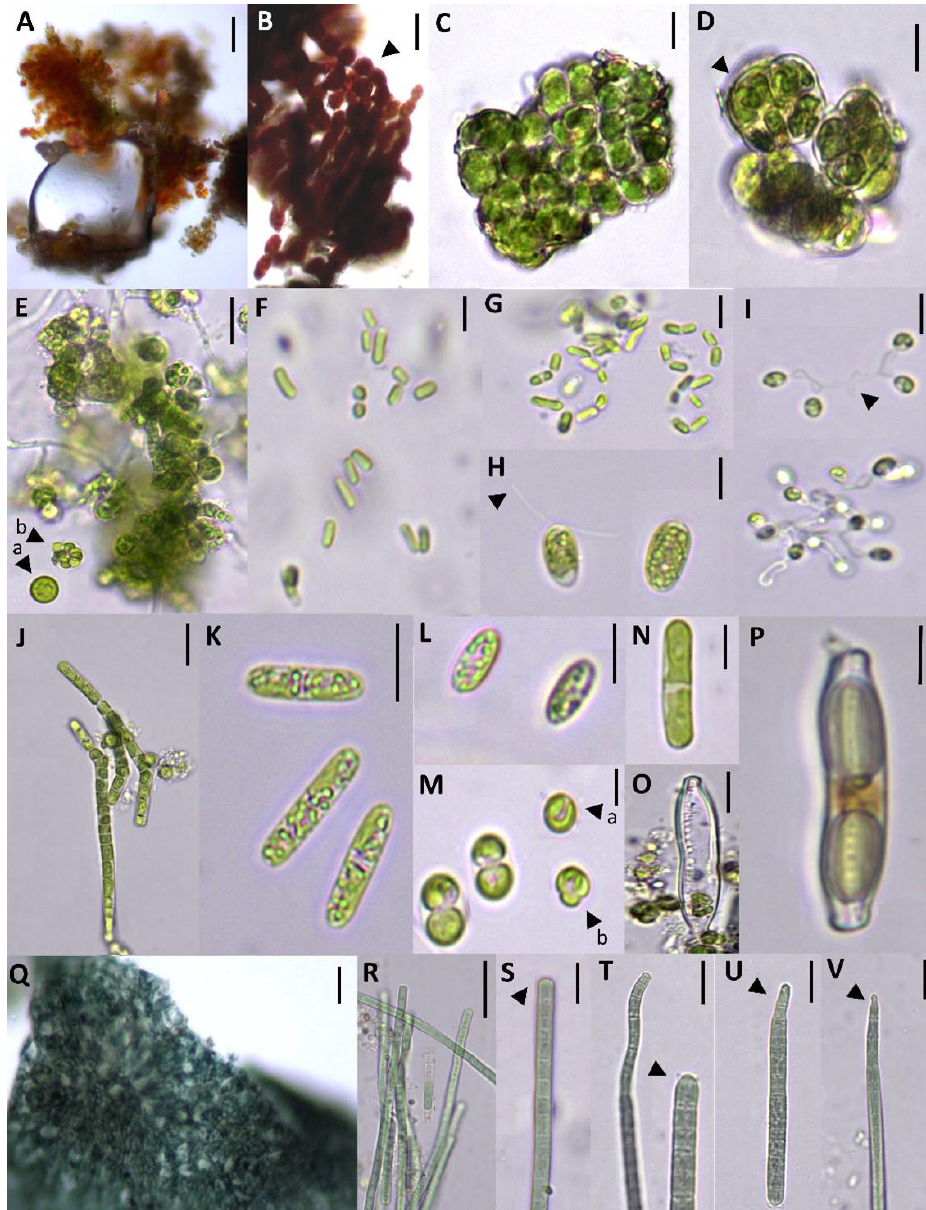
Figure 2. Species/taxa identified in the different samples observed on the surface of the north- and west-facing walls of the SMV, ROC and BAR churches. Chlorophyta or green algae ( A – N ): ( A , B ) Trentepohlia cf. umbrina (the arrow indicates the characteristic constriction of the filament cells); ( C , D ) Desmococcus olivaceus , genus appearance and cell details (arrow indicates central chloroplast pyrenoid); ( E ) Bracteacococcus minor (arrow indicates cell details and autospore); ( F ) Stichococcus bacillaris ; ( G ) Stichococcus mirabilis ; ( H ) Chlamydomonas sp . (arrow indicates one of the flagella); ( I ) Dictyosphaerium chlorelloides (Nauman) (arrow indicates mucilaginous tracts between cells); ( J ) Klebsormidium cf. flaccidum (Kützing); ( K ) Mesotaenium cf. caldariorum ; ( L ) Elakatothrix gelatinosa ; ( M ) Chlorella vulgaris (the arrows indicate in detail the morphology of the chloroplast ( A ) and the four-celled autospore ( B )); ( N ) Cylindrocystis brebissoni ; Bacillariophyta or diatoms: ( O , P ) Hantzschia amphyoxis, detail of siliceous frustule ( O ) and living cell ( P ); Cyanophyta ( Q – V ) (arrows indicate characteristic terminations of trichomes): ( Q ) Cyanobacterial film found on ROC church walls; ( R , S ) Tychonema cf. bourrellyi ; ( T ) Oscillatoria tenuis ; ( U ) Phormidium autumnale ; ( V ) Phormidium favosum (Scales: A – C , J , Q , R = 20 µ m; D – I , K – N , S – V = 10 µ m; O – P = 5 µ